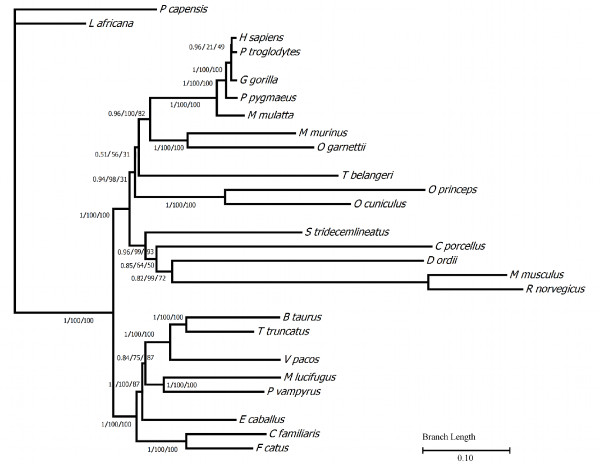
Phylogenetic tree of MEPE intronic regions. Phylogenetic depiction of the MEPE intronic region tree reconstructed using Bayesian inference (Bayes), Maximum Likelihood (ML) and Neighbor-Joining (NJ) algorithms. The labels are positioned near the branches supporting the tree and inside the brackets (Bayes/ML/NJ). The methodology was similar to the implemented in the coding regions. The alignment of the intronic regions comprehends 856 out of 21120 sites completely clean of gaps in all the species (except for the Macaca mullata since the intronic regions was not available).